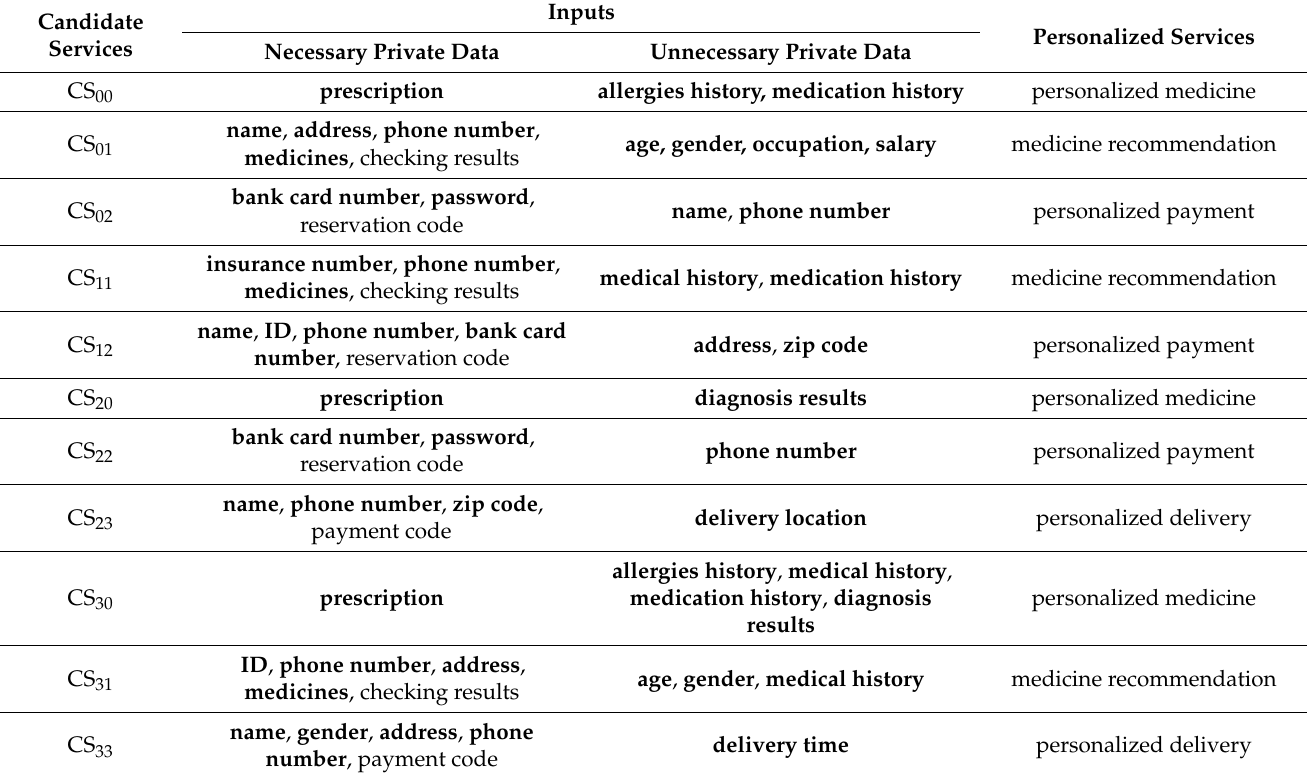
Table 2. The input data and personalized services of the candidate